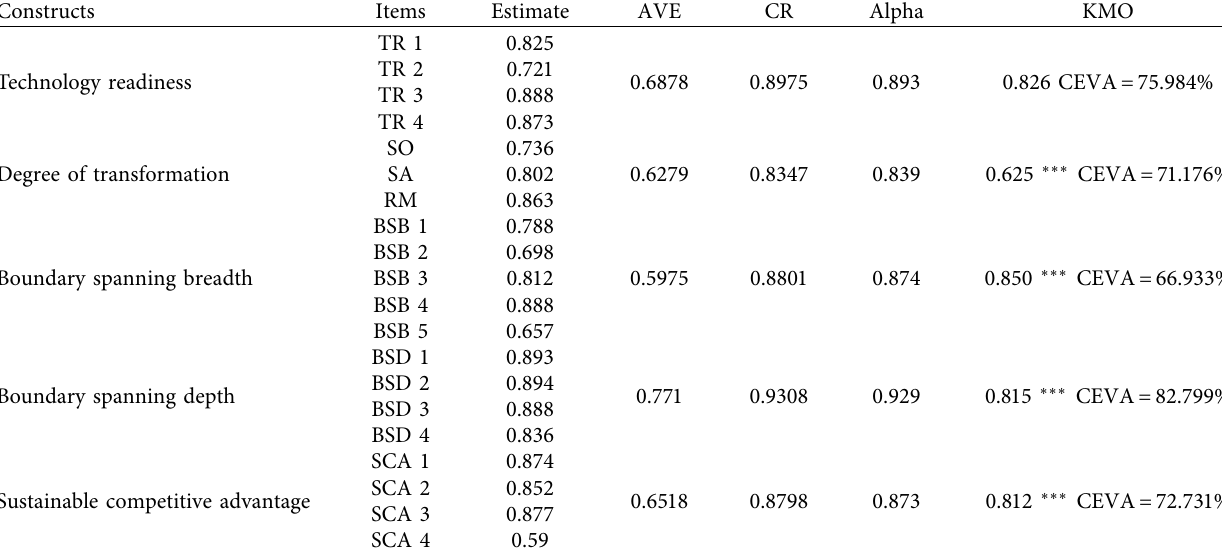
Table 2: Reliability and validity analysis of each variable.